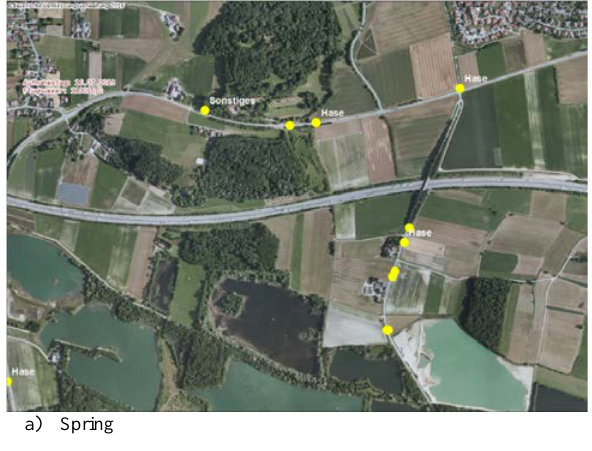
in the hilly forests in the north.